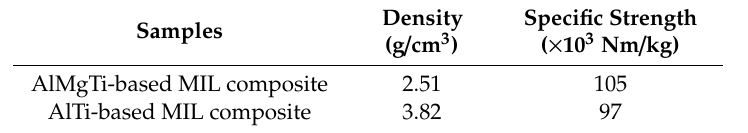
Figure 7. Crack morphology of four kinds of typical areas of AlMgTi-based bending sample: ( a ) Aluminum-magnesium diffusion layer; ( b ) Aluminum metal layer ( c ) Magnesium metal layer ( d ) Aluminum-titanium diffusion layer. Another obvious difference that can be found through Figure 7a,c is that the cracks at the metal diffusion layers are vertical, while the cracks at the metal layers are inclined to expand, with a growth direction of 45° or 135°. Concurrently, the main cracks of the base metal layer are accompanied by many branch cracks, which will stop extending for a certain distance in the ductile layers, and the crack passivation phenomenon will occur at the crack tip. The above situation is due to the brittleness of the diffusion layers and ductile fracture of the aluminum layers. The increase in the crack growth path in the ductile layers consumes more energy, and makes the fracture difficult to occur, enhances the bending strength of the material, and forms more descending tiny steps in the stress–strain curve as shown in Figure 5. In Figure 7b, it is shown that the aluminum metal layer will undergo strong deformation when it breaks. The aluminum layers with good plasticity will absorb energy and be